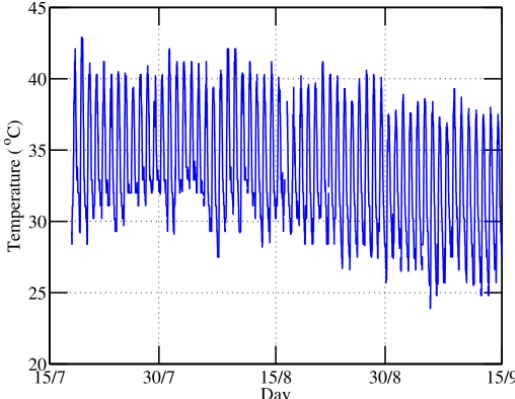
Figure 8. Air temperature recorded during experiment.